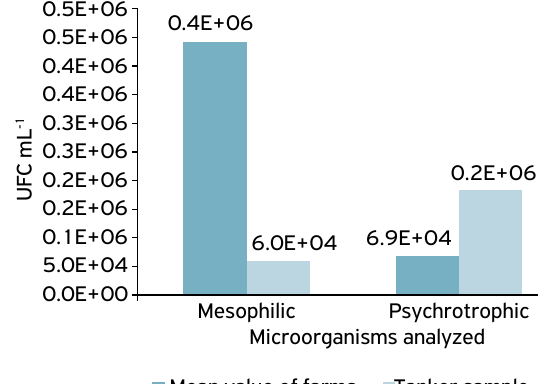
Figure 1. Percentage of compliant and non-compliant milk samples with the limit for mesophilic and psychrotrophic microorganisms permitted by the referred legislation.